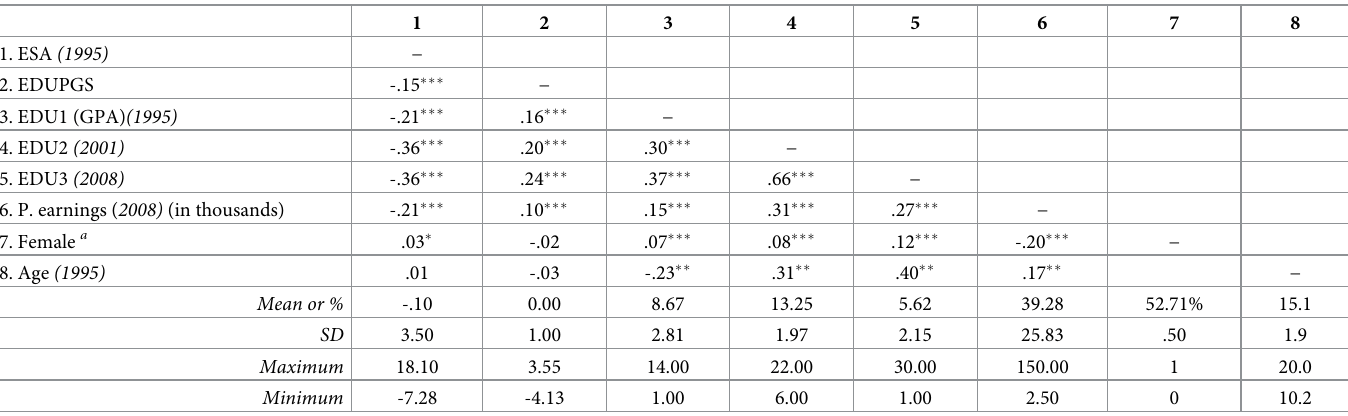
Table 1. Correlations, Means, and Standard deviations among study variables.